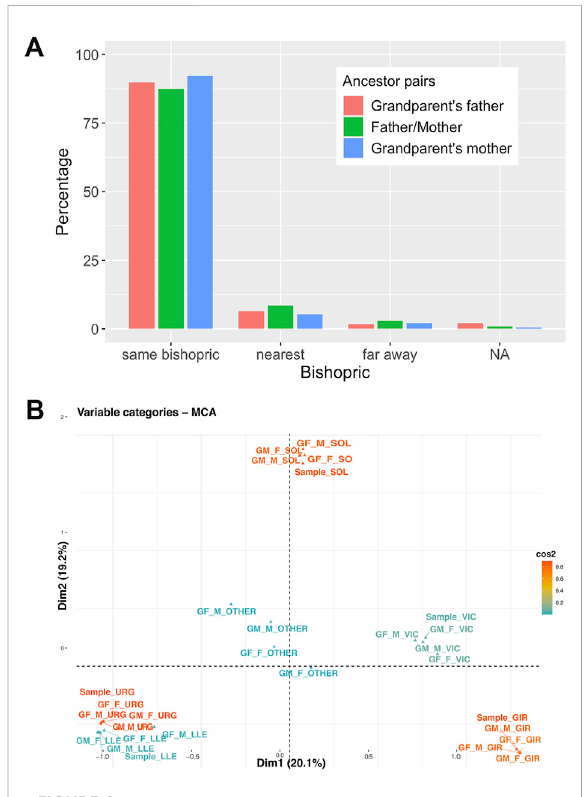
FIGURE 9 (A) Relationship of marriages depending on the bishoprics of parents and grandparents couples. (B) Multiple Correspondence Analysis between the bishopric of the sample and her/his parents and